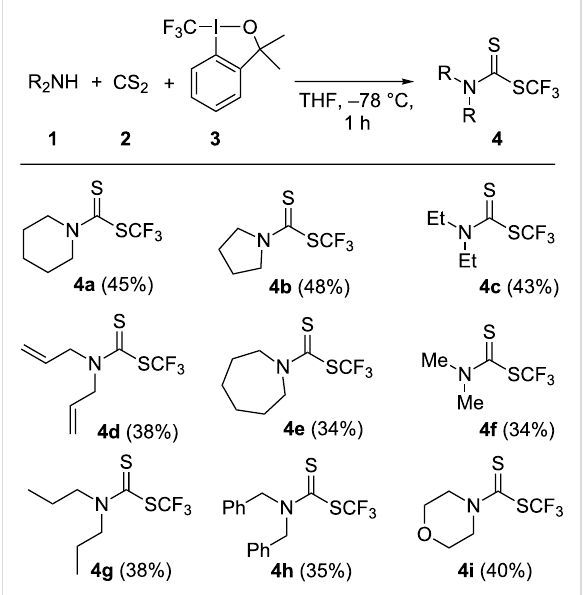
Scheme 2: Synthesis of S -trifluoromethyl dithiocarbamates. Isolated yields are given in